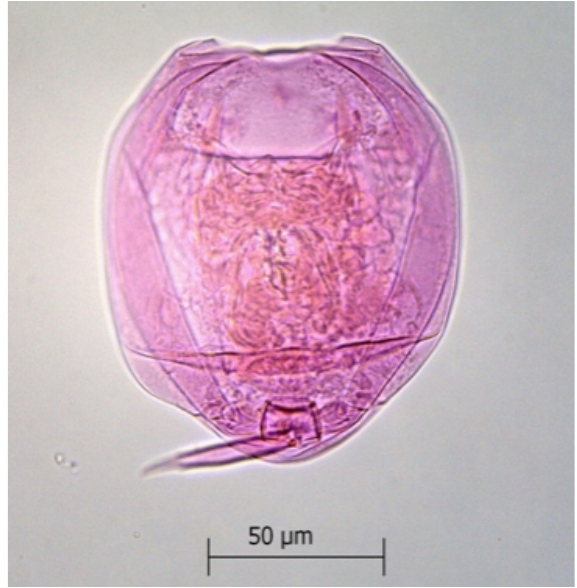
Image 2. Lecane unguitata (Fadeev), ventral view